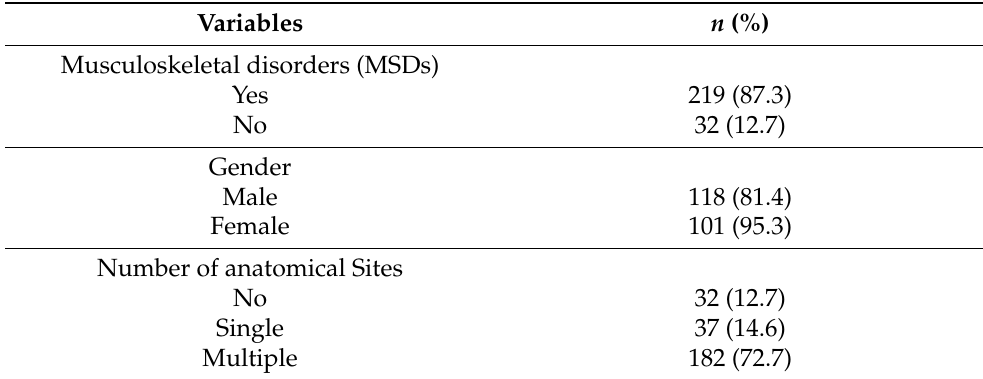
Table 2. Prevalence of musculoskeletal disorders ( n =